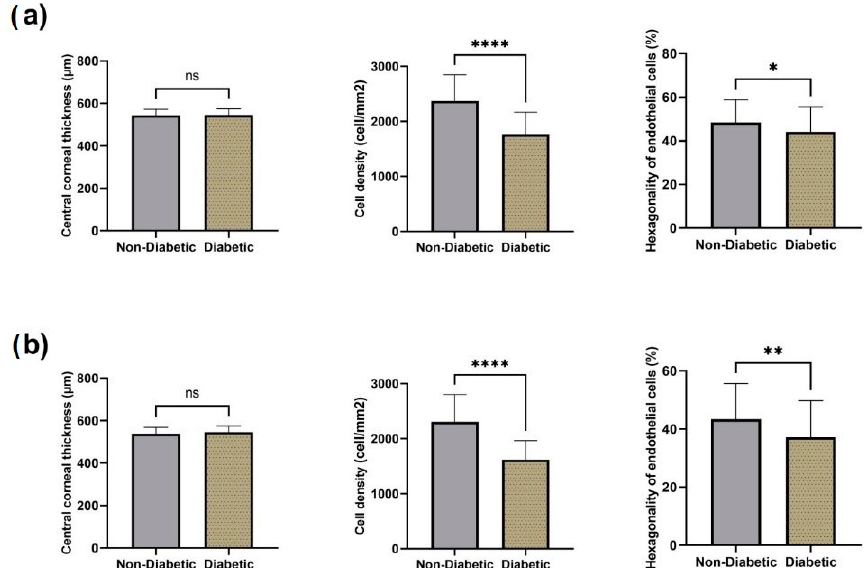
Figure 7. Effect of diabetes on surgical outcomes, including central corneal thickness, cell density, and hexagonality of endothelial cells postoperative at 1st week ( a ) and at 4th week ( b ). Data are presented as mean ± SD and compared using unpaired t -test. Legend: ns—non-significant, * p < 0.05, ** p < 0.01, **** p < 0.0001.